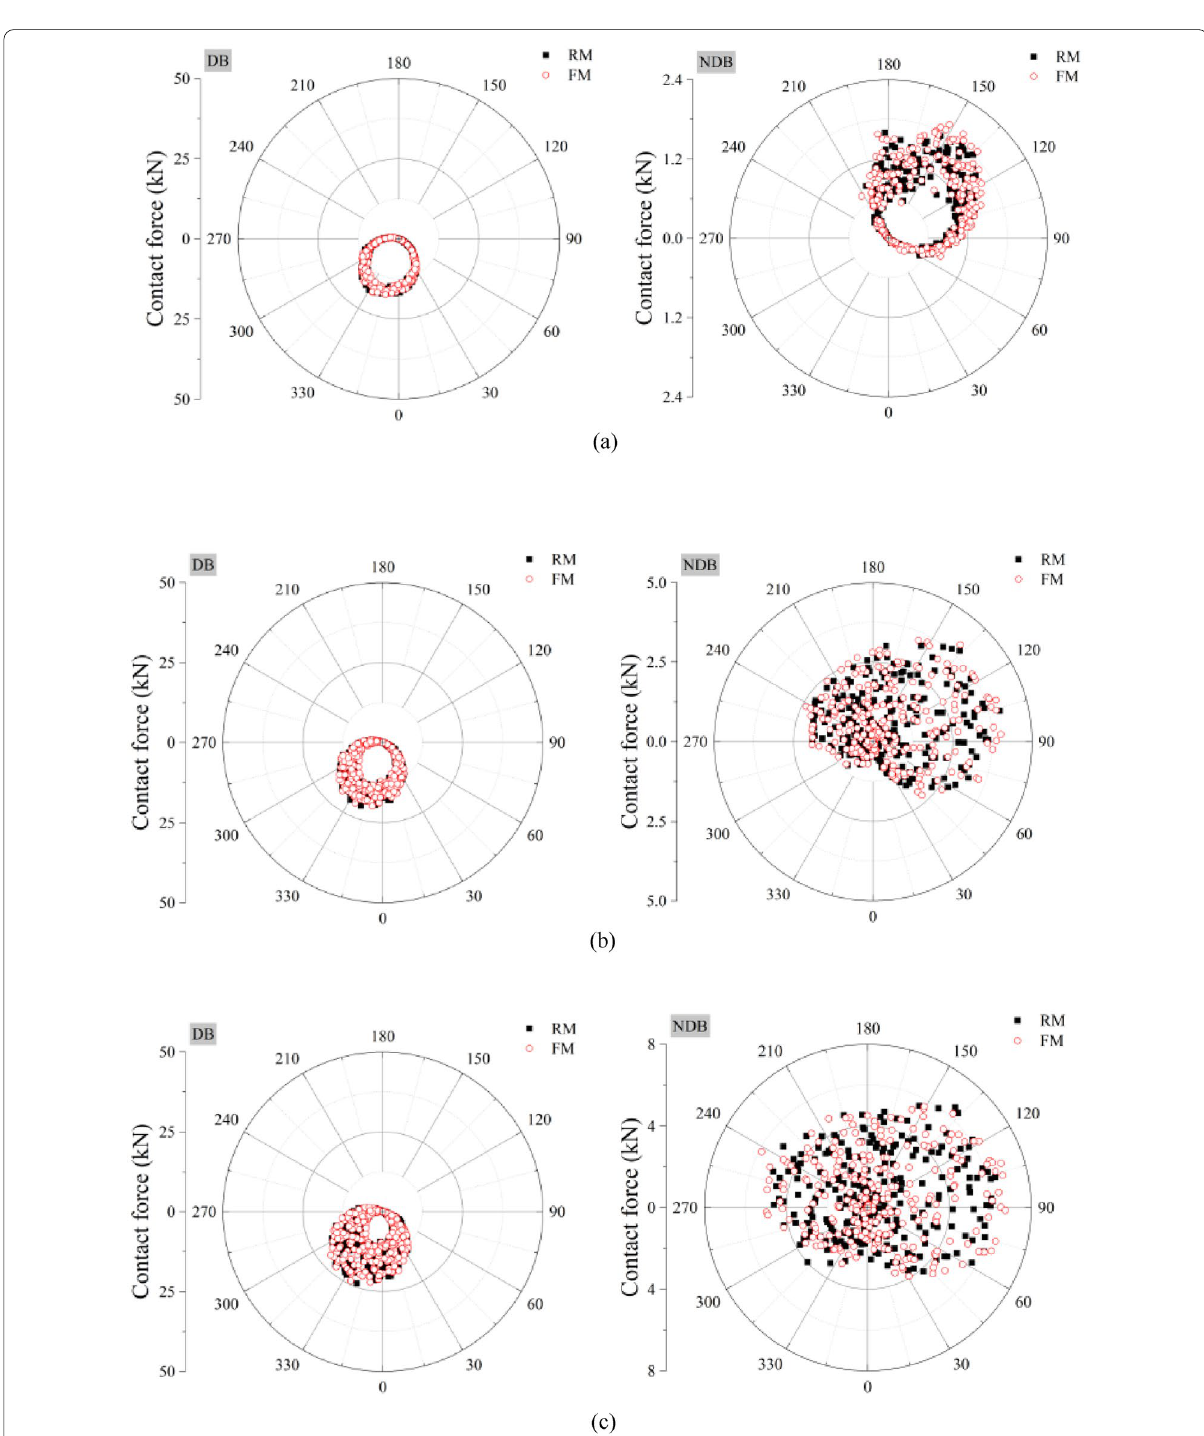
Figure 14 Effect of rotor eccentricity on roller-race contact forces of driving and non-driving end bearings: a 0 mm, b 0.2 mm, c 0.4 mm, d 0.6 mm, e 0.8 mm, and f 1.0